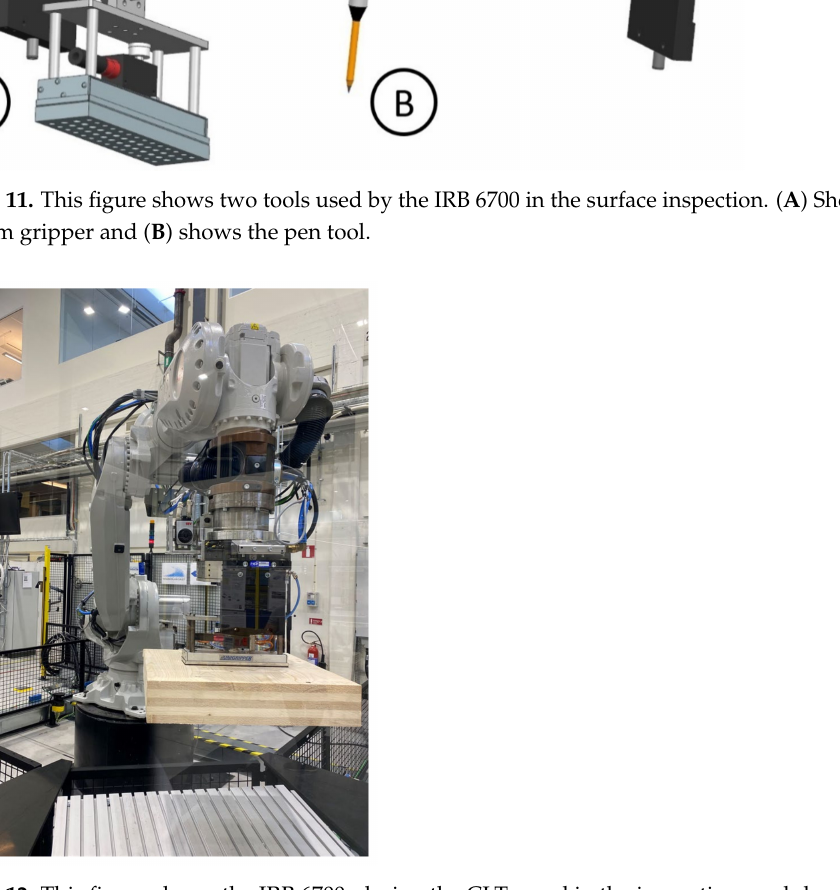
Figure 12. This figure shows the IRB 6700 placing the CLT panel in the inspection module.